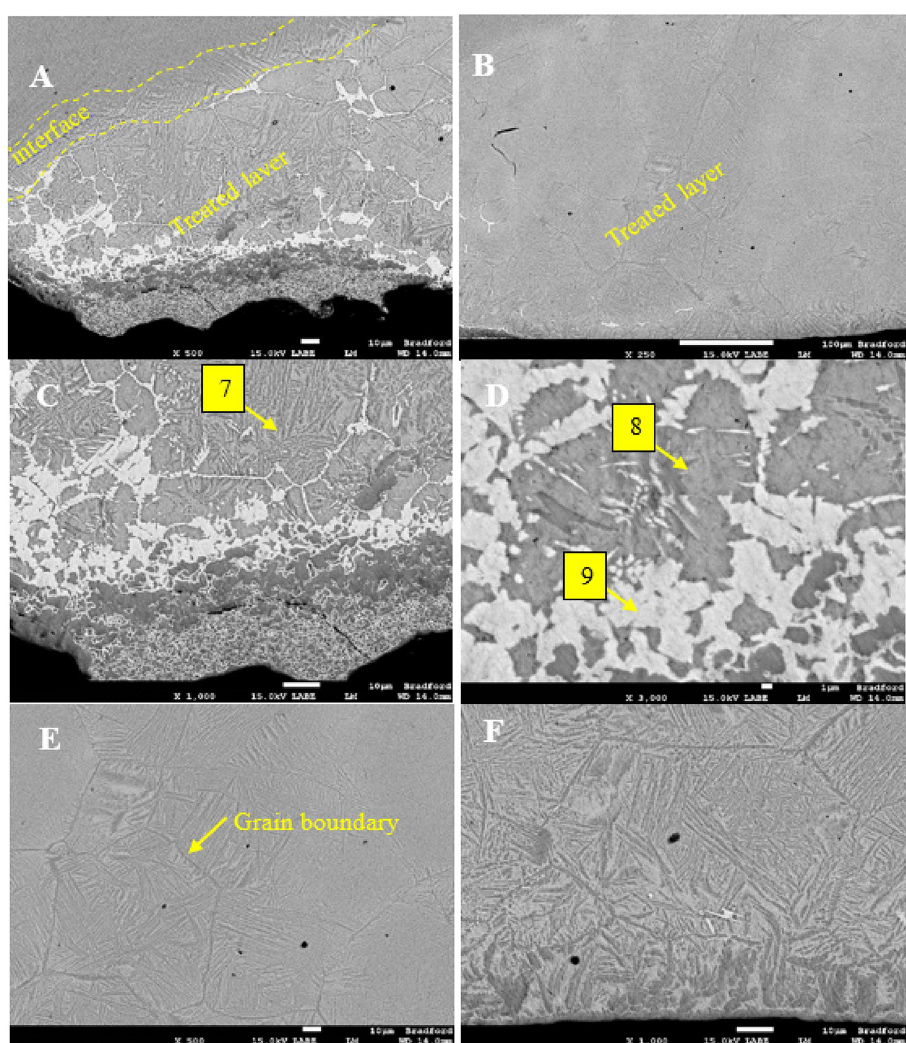
Figure 5. ( A ) The treated surface of the Ti-6Al-4 V alloy Ni coating containing 30 nm TiO 2 /40 nm Al 2 O 3 ( B )